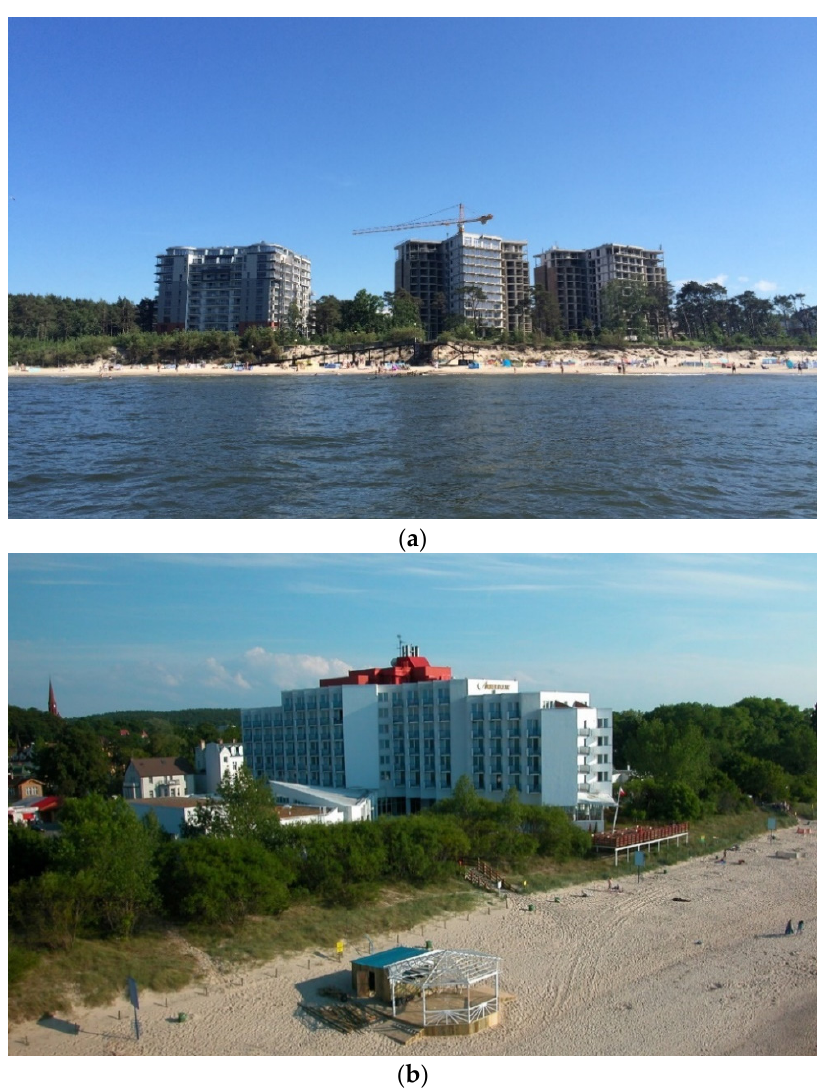
Figure 10. Intensive development of seaside resorts. Source: Author’s work ( a ), C. Skórka, 4Dfoto ( b ).